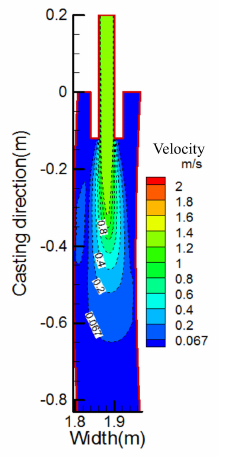
Figure 2. The velocity field of molten steel in the mold.